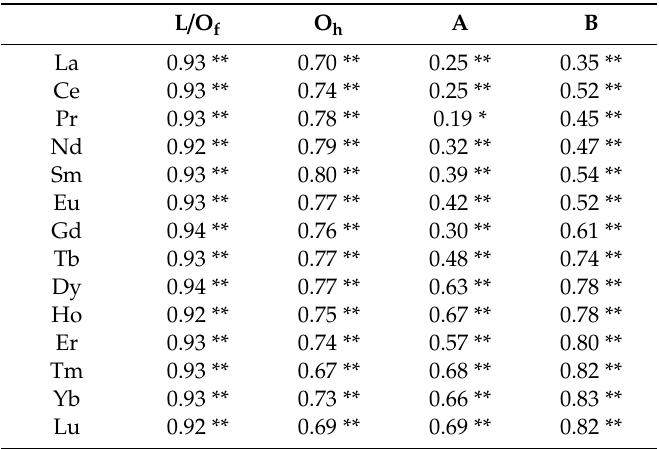
Table 3. Spearman correlations coe ffi cients on the association between rare earth elements (REEs) concentration and U concentration for the four horizons (L / O f , O h , A, and B). Significant di ff erences were indicated by ** p ≤ 0.01, * p ≤